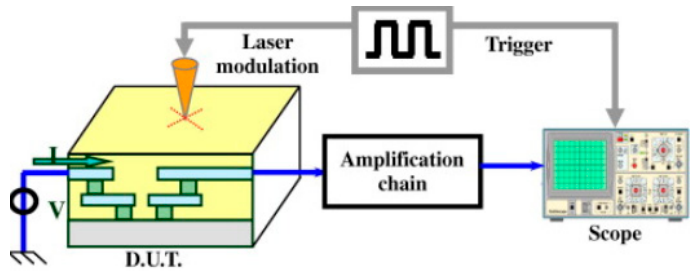
Figure 13. Principle of laser-assisted device alternation.